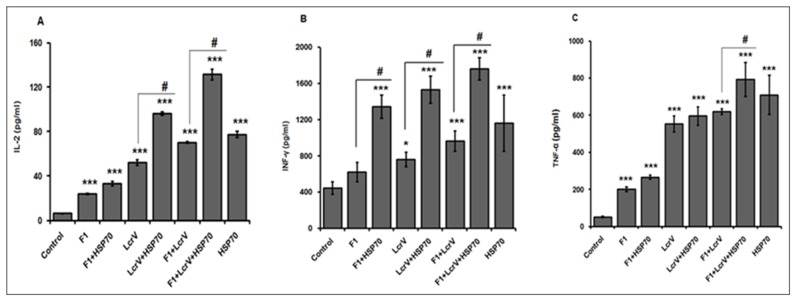
Measurement of cytokines expressed by splenocytes of immunized mice groups.Cytokines expressed by splenocytes collected from mice immunized with F1, F1+HSP70(II), LcrV, LcrV+HSP70(II), F1+LcrV+HSP70(II) and HSP70(II) including control group were measured. Concentrations of cytokines detected in splenocytes supernatant after 48 h of stimulation with specific antigens (5 µg/ml) are shown. Graphs showed concentrations of (A) IL-2, (B) IFN-γ, (C) TNF-α in picograms per millilitre (pg/ml). Each bar represents the average of 8 mice/group ± S.D and is representative of three independent experiments. Analysis was done by one way ANOVA, All Pairwise Multiple Comparison Procedure (Fisher LSD Method). *P<0.05; **P<0.01; ***P<0.001; #P<0.001.